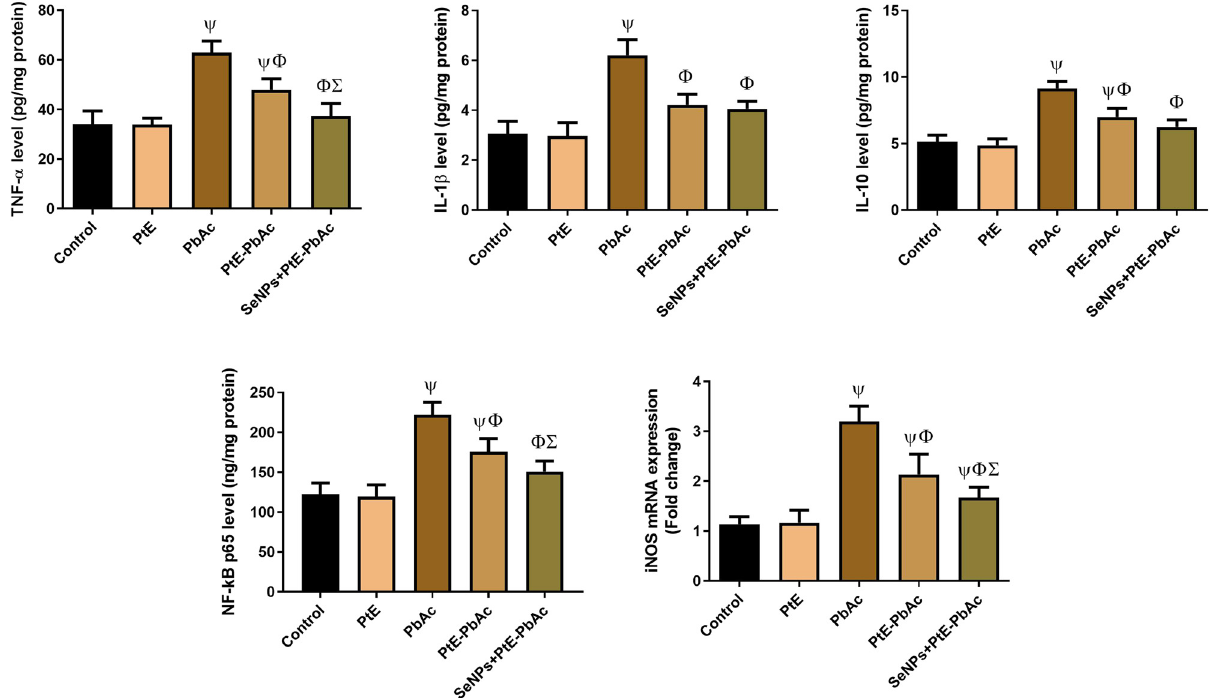
Figure 5: E ff ects of orally administered PtE or PtE - SeNPs on the levels of neuroin fl ammatory biomarkers ( IL - 1 β , TNF - α , IL - 6, and NF - κ B ) and the mRNA expression levels of Nos2 in the brain of PbAc - injected rats. ψ , Φ , Σ superscript letters indicate statistical signi fi cance at P < 0.05 against control, PbAc, and PtE - PbAc group, respectively. All results are presented as the mean +